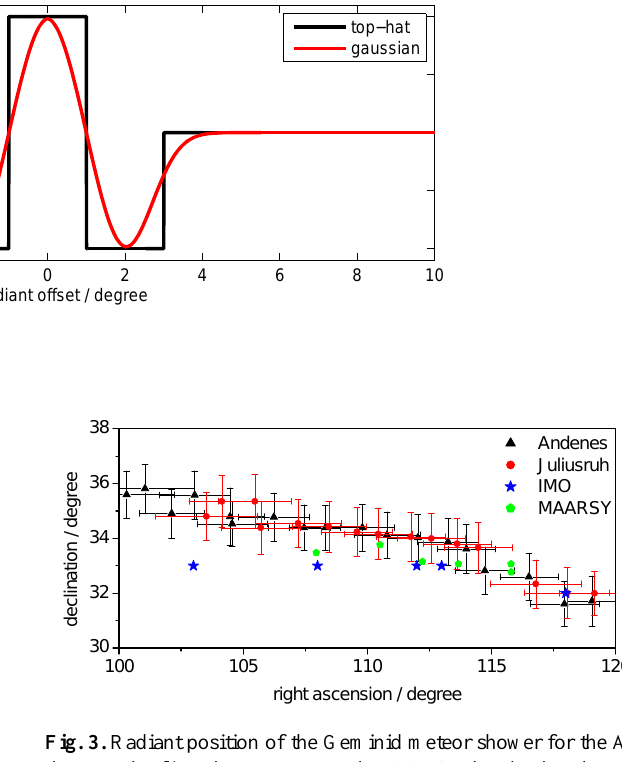
Fig. 3 represent the width (extension) of the source radiant in right ascension and declination, which is defined by the applied weighting function and the measurement errors. The width of the weighting function is based on the MR inter-